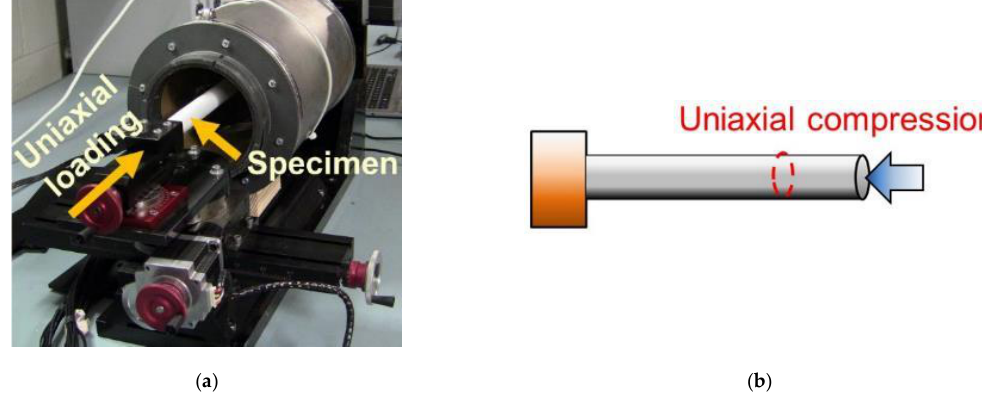
Figure 6. ( a ) The picture of the load frame and ( b ) the schematic shows that uniaxial compressive load was applied to the test specimen, and ECT measurments were recorded at different strain states.